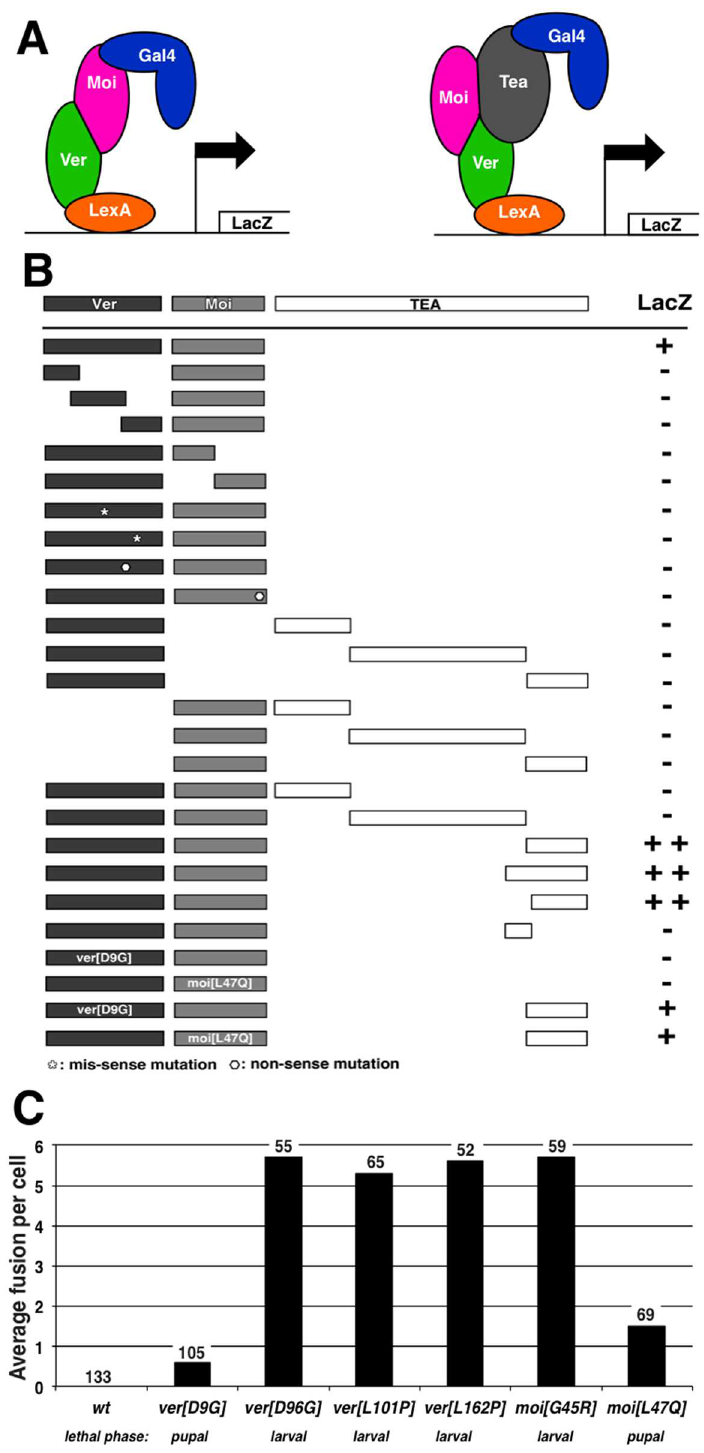
Fig 3. Characterization of MTV interaction with yeast two-hybrid and genetic mutations. A : schematic illustrations of yeast two-hybrid(left) and three-hybrid (right) assays. In yeast three-hybrid,either Moi or Ver were expressedas “stand-alone” proteins. B : diagrams summarizing the yeast two/three hybrid results. Moi and Ver interact in yeast two-hybrid and Moi, Ver and C-terminalTea interact in yeast three hybrid. Black and grey rectangularboxes indicate the extent of Ver and Moi proteins expressed respectively. We